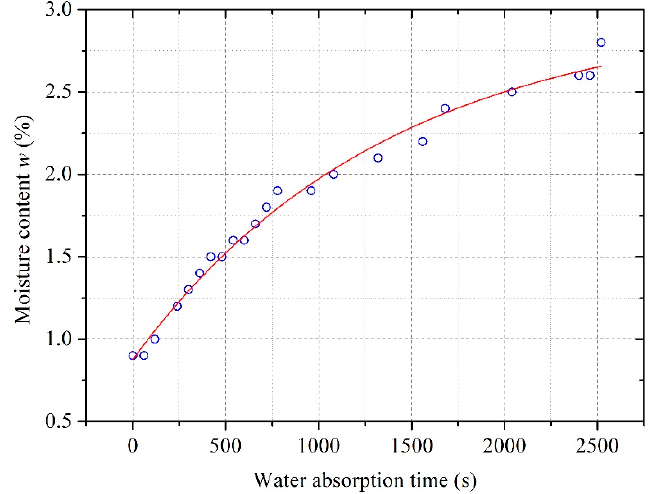
Figure 1. Relationship between the duration of water absorption and the moisture content of the pressboard samples.